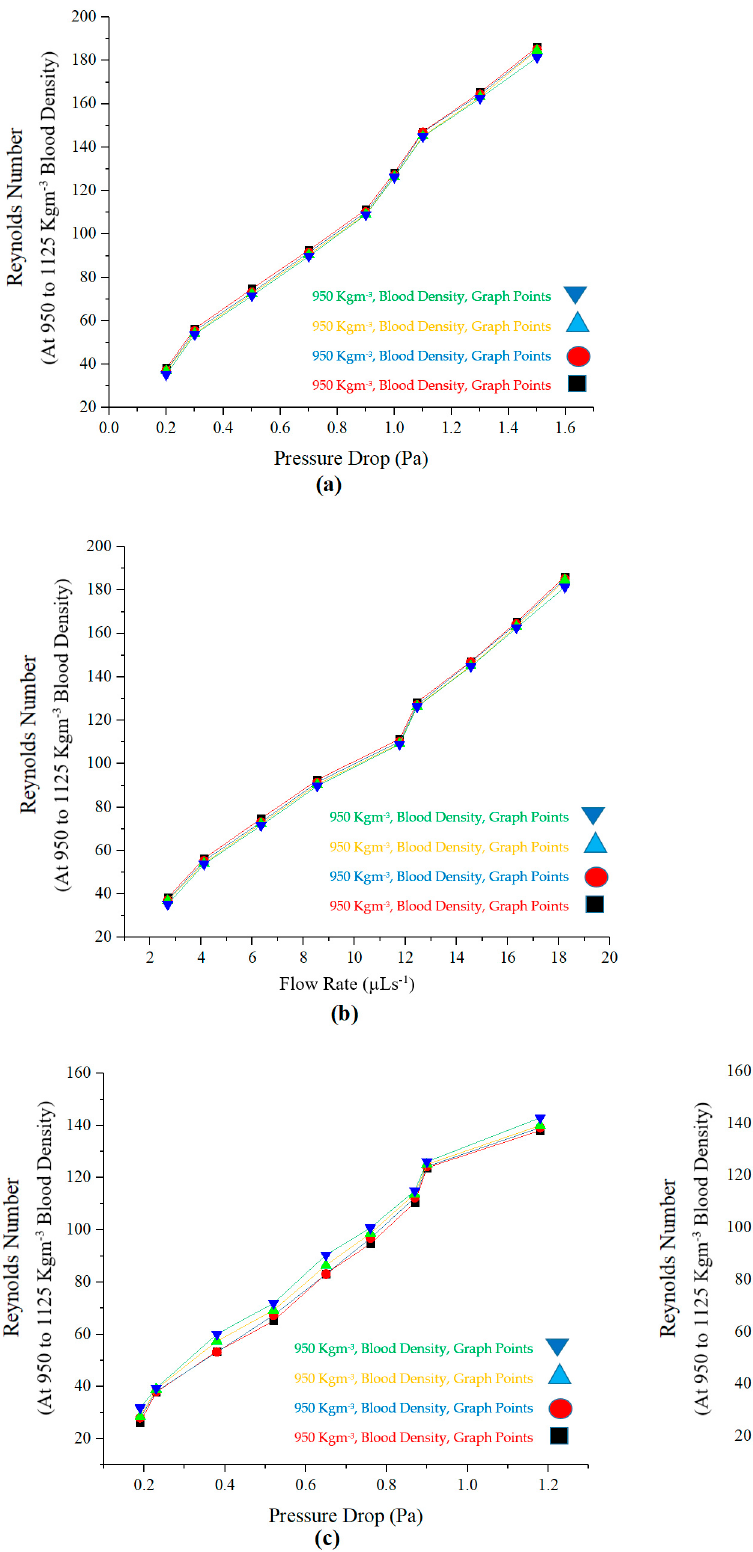
Figure 16. Experimental graphs ( a ) Reynolds number and pressure drop for 5CACMC ( b ) Reynolds number and flow rate for 5CACMC ( c ) Reynolds number and pressure drop for 5CDCMC ( d ) Reynolds number and flow rate for 5CDCMC.